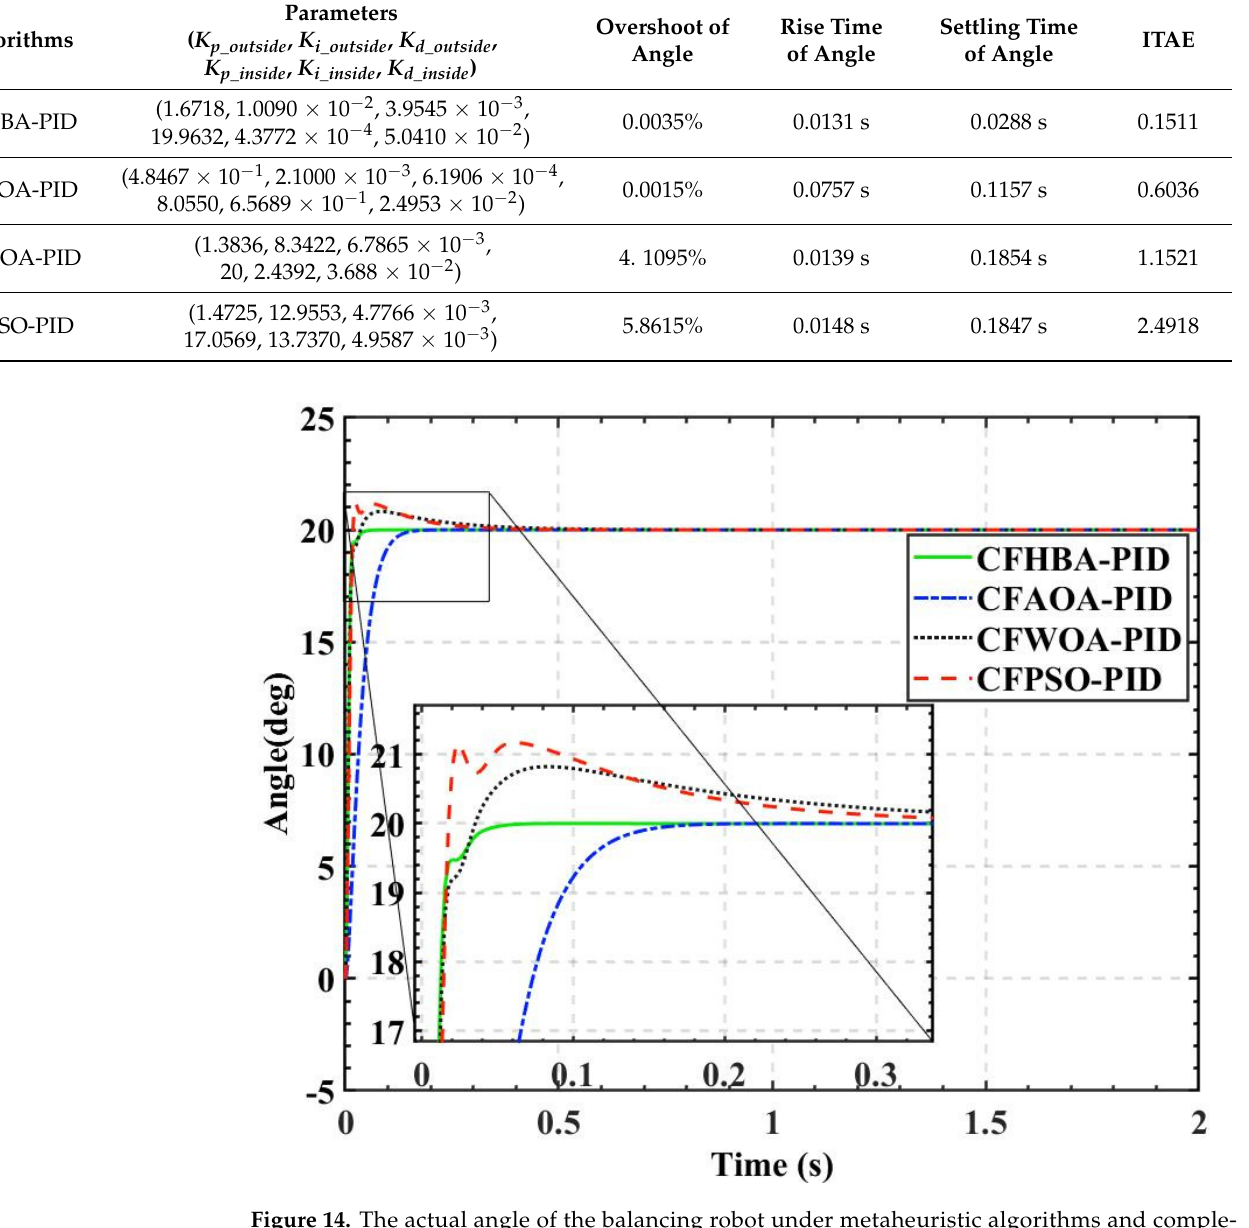
Figure 14. The actual angle of the balancing robot under metaheuristic algorithms and complementary factor. Table 7. Attitude control of balancing robots under metaheuristic algorithms and complementary factor.